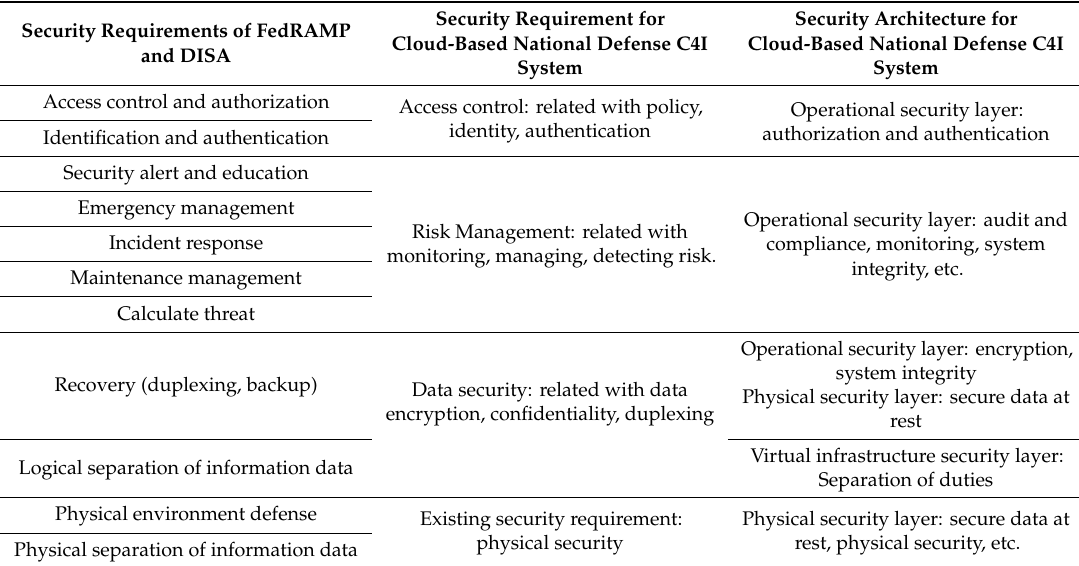
Table 4. Comparison between Security Requirements and Security